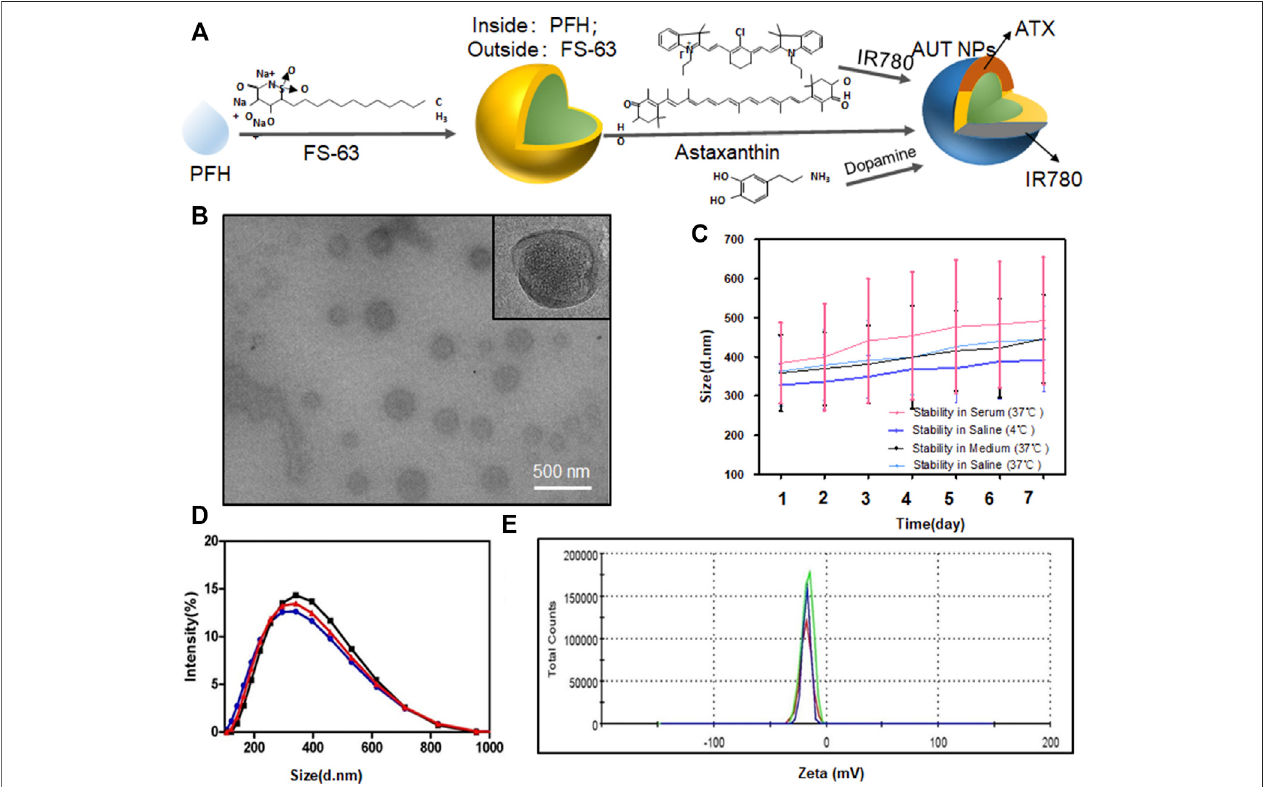
FIGURE 1 | The characterization of AUT NPs. The structural diagram of AUT NPs (A) . The TEM results of AUT NPs (B) . The stability of AUT NPs under different solvent conditions (C) . The size (D) and Zeta potential (E) distribution of AUT NPs ( n (cid:2) 3).